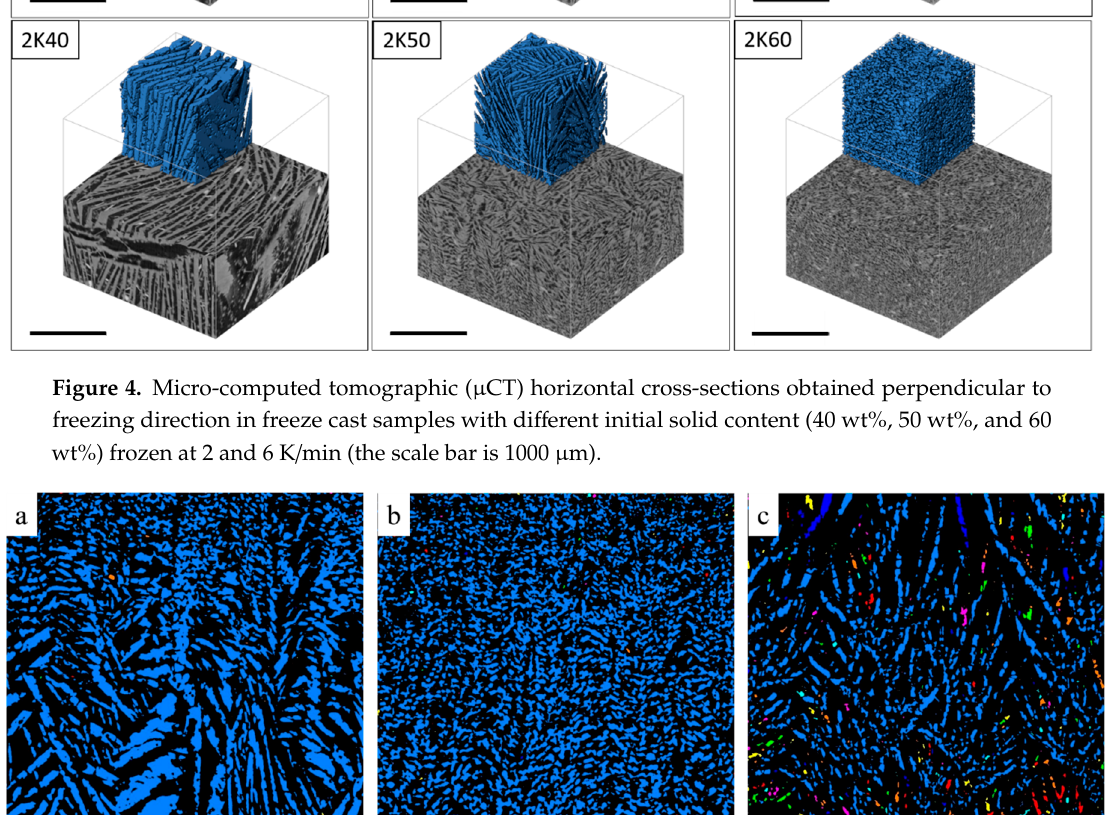
Figure 5. µ CT images of the cross-section of 2K50 ( a ), 2K60 ( b ), and 6K50 ( c ) samples parallel to freezing direction. Connected pores touching the upper and lower sample boundary are displayed in blue, other colors represent trapped pores.